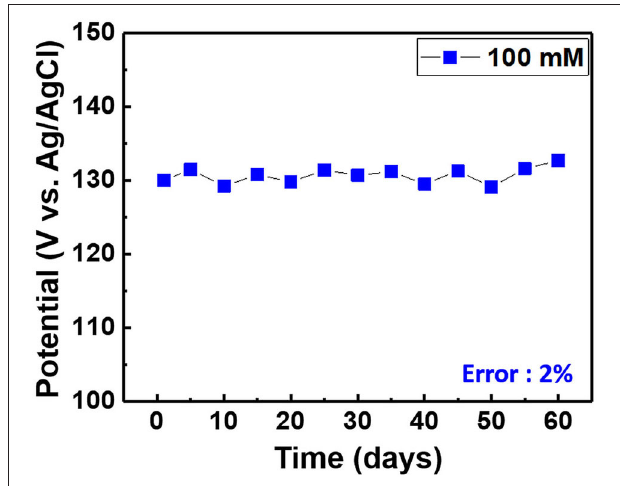
FIGURE 10 | Long-term stability of the chloride ion sensor in the electrolyte comprising 100mM KCl and 0.5 M KNO 3 .